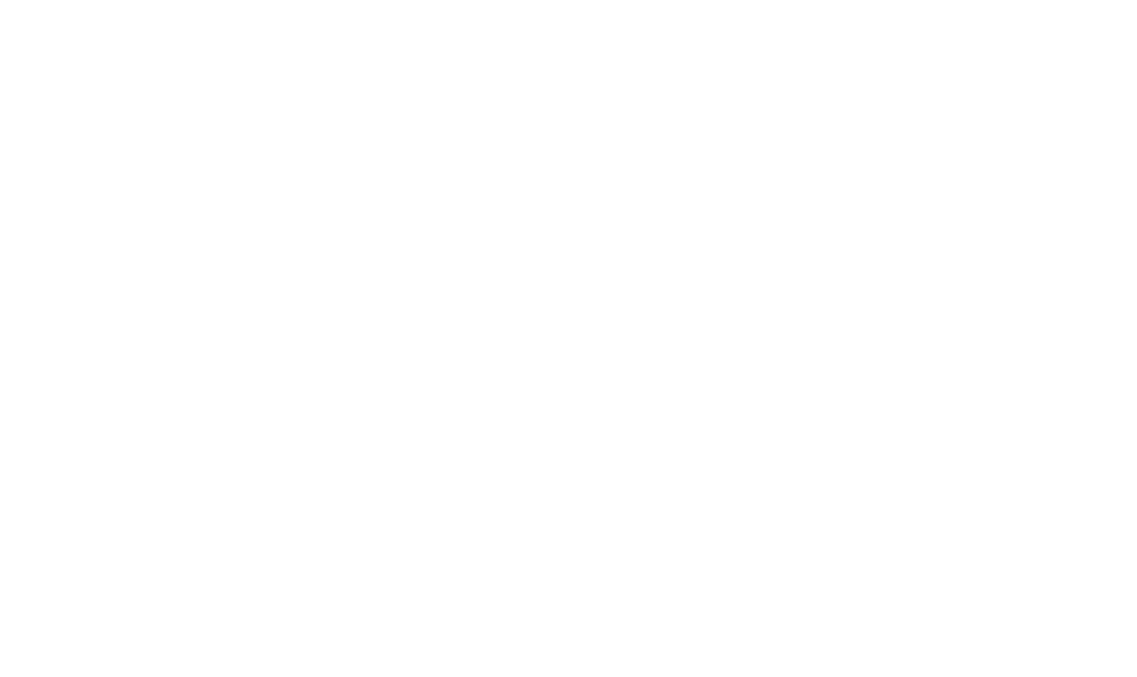
Frontiers in Chemistry |